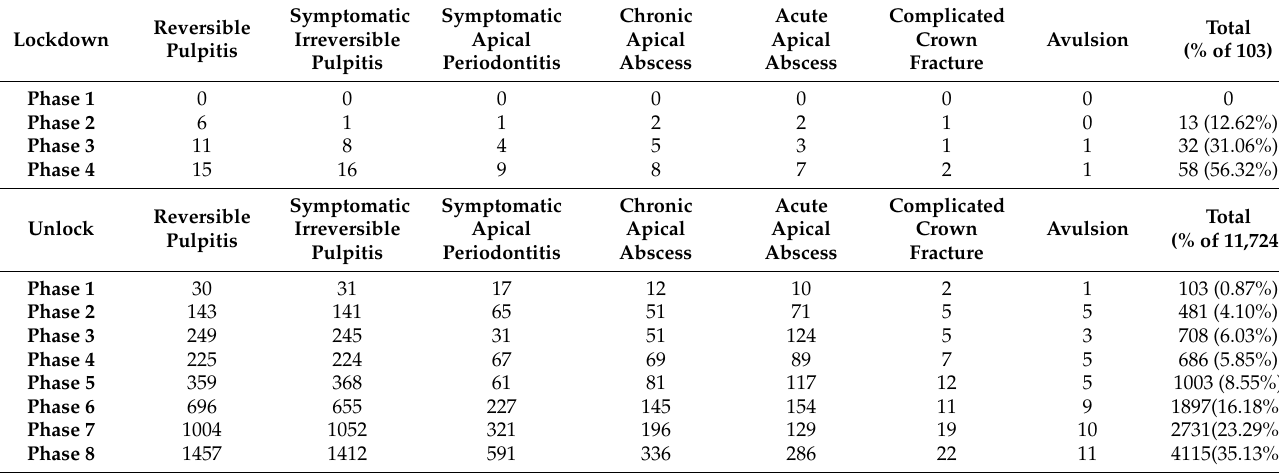
Table 5. Number of patients that visited the dental school for their second/follow-up visit for different endodontic emergencies during the lockdown and unlock phases.